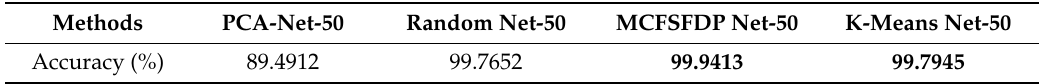
Table 5. The testing accuracy of different CNNs methods which compared with K-means Net on Dataset 1. Methods